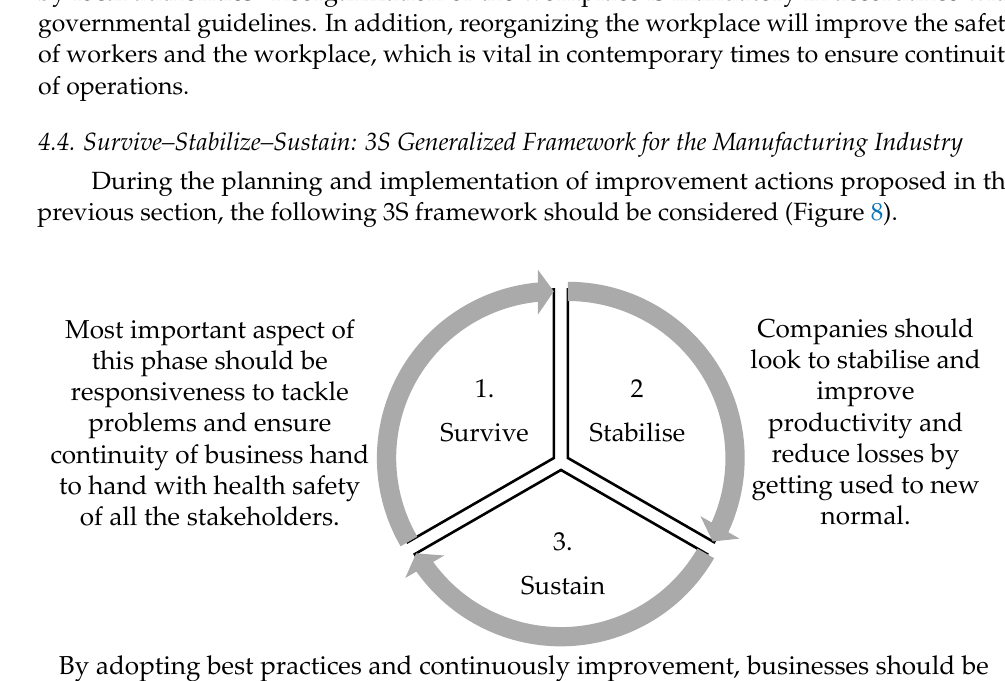
Figure 8. Generalized 3S framework of good/best practices for manufacturing industry.